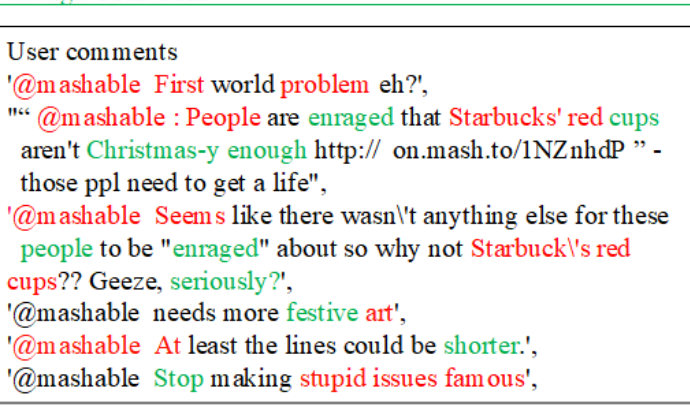
Figure 1. A fake news example from Twitter 15, where the red words represent the highlighted words in every single sentence by the attention mechanism for current fake news detection models, and the green words are post-related tokens, which should be paid attention to in source posts and user comments when confirming the truthfulness of the